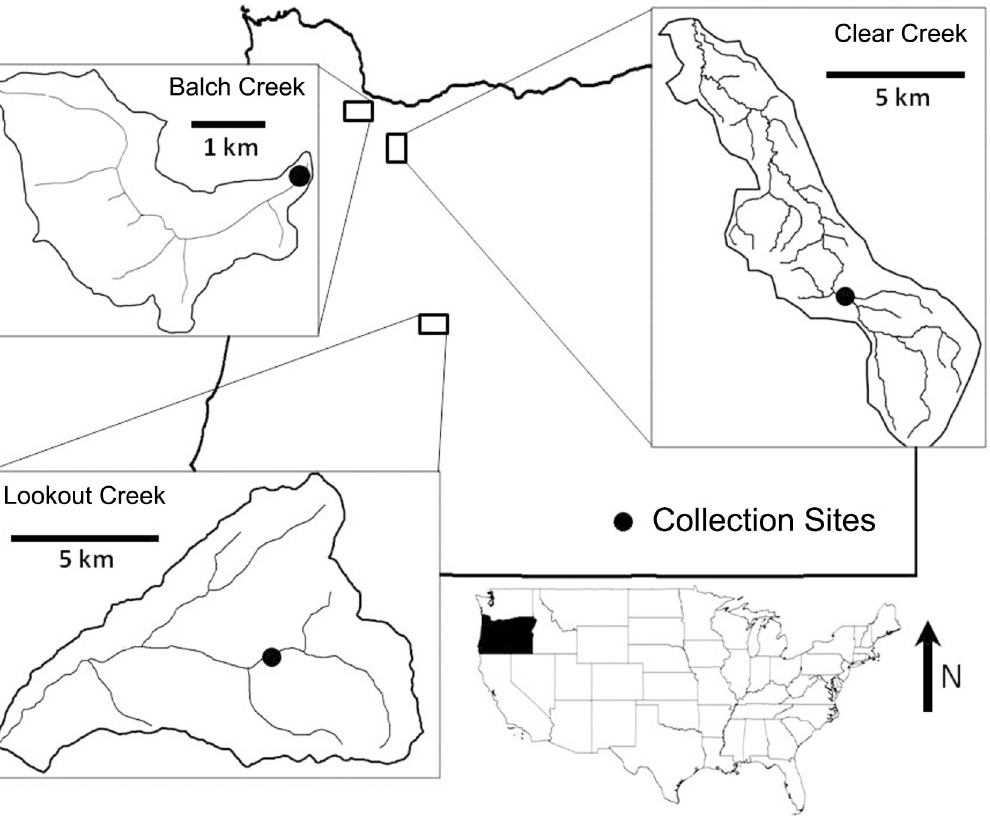
Fig 2. Map of study watersheds and data collection sites in Oregon, United States. Black circles show data collection sites. Map scale is indicated within each watershed map.